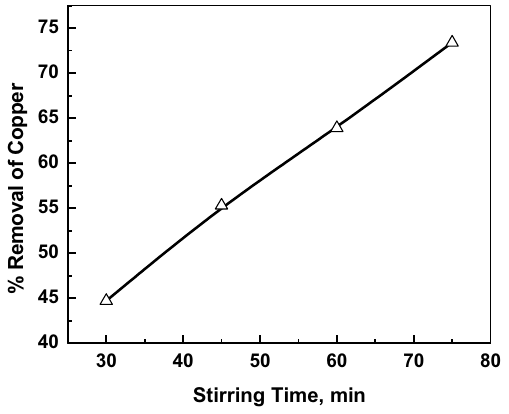
Fig. 6 Effect of variation in contact time